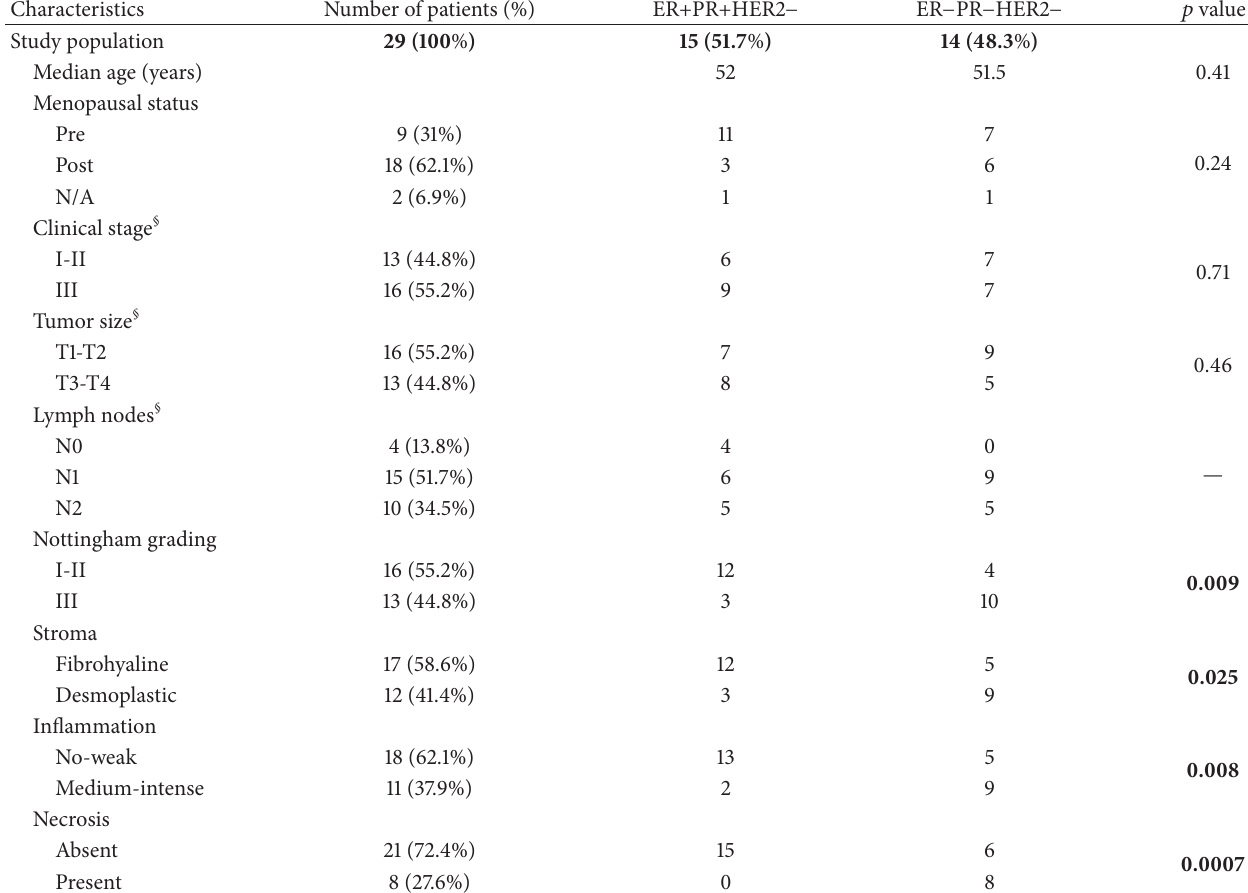
Table 2: Association between ER, PR status and clinicopathological